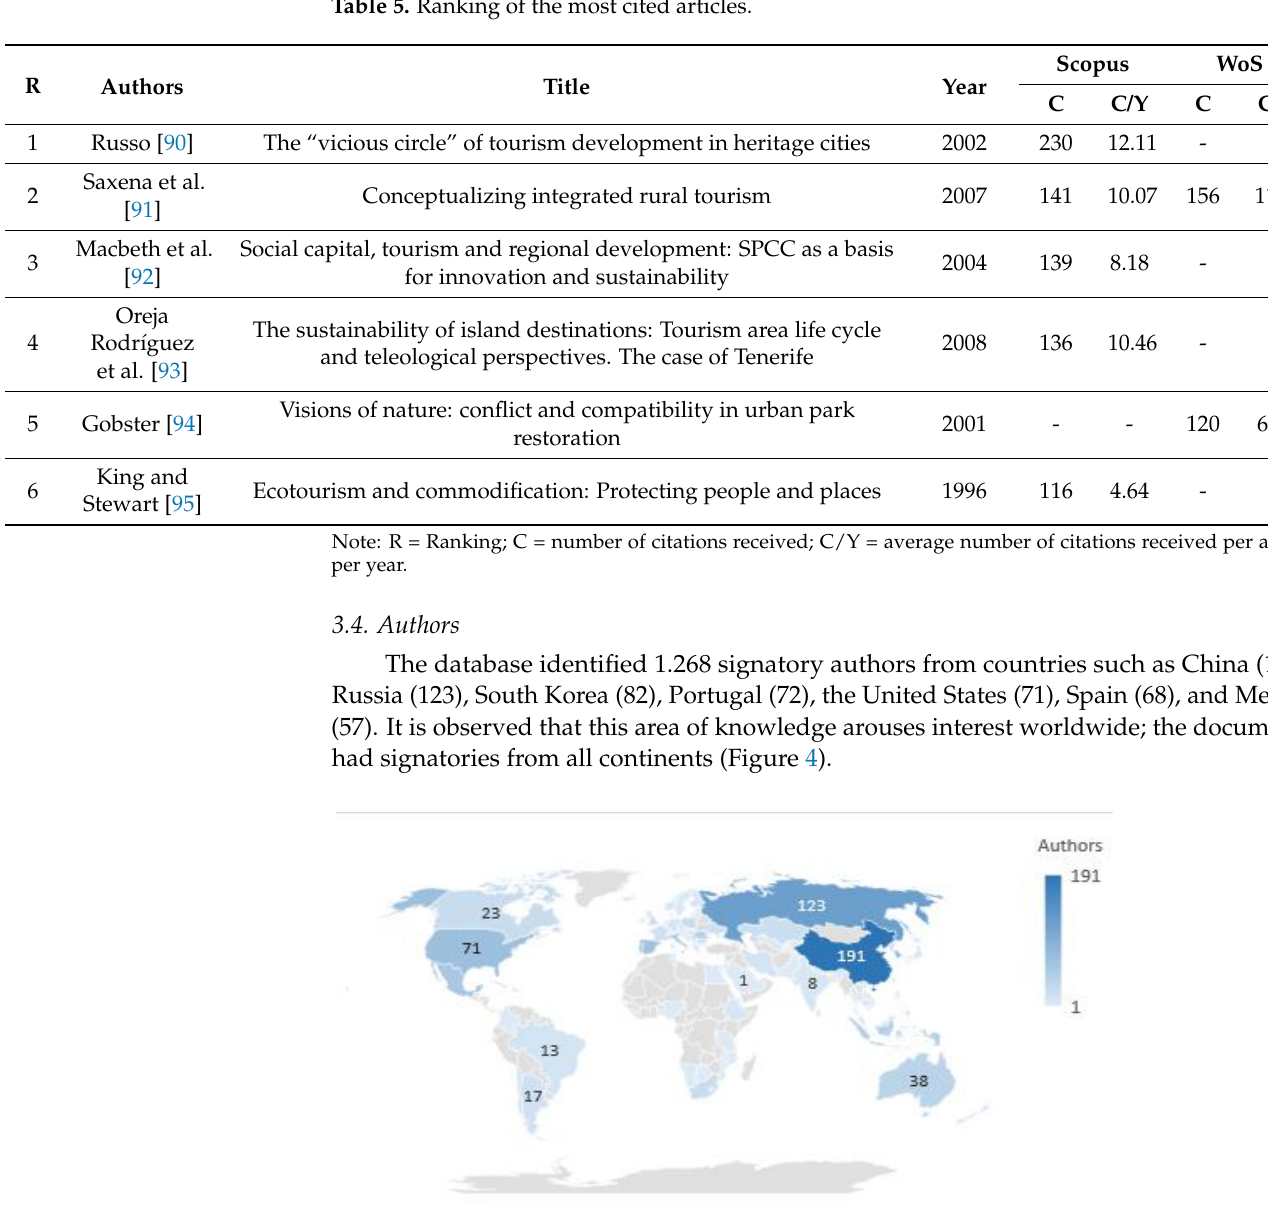
Figure 4. Distribution of authors by country. Source: Authors’ own data .